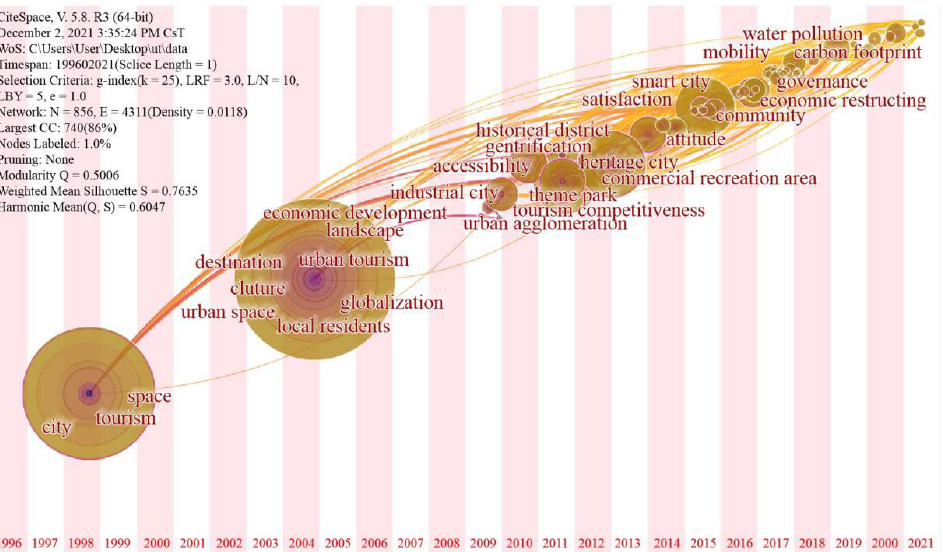
Figure 1. Annual number of publications on urban tourism from 1996 to 2021.